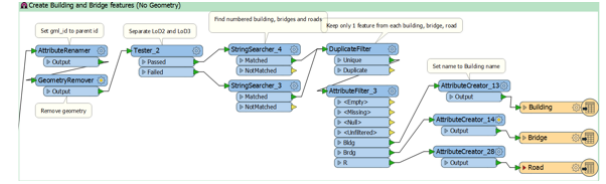
Figure 2: The Feature Types of the Model